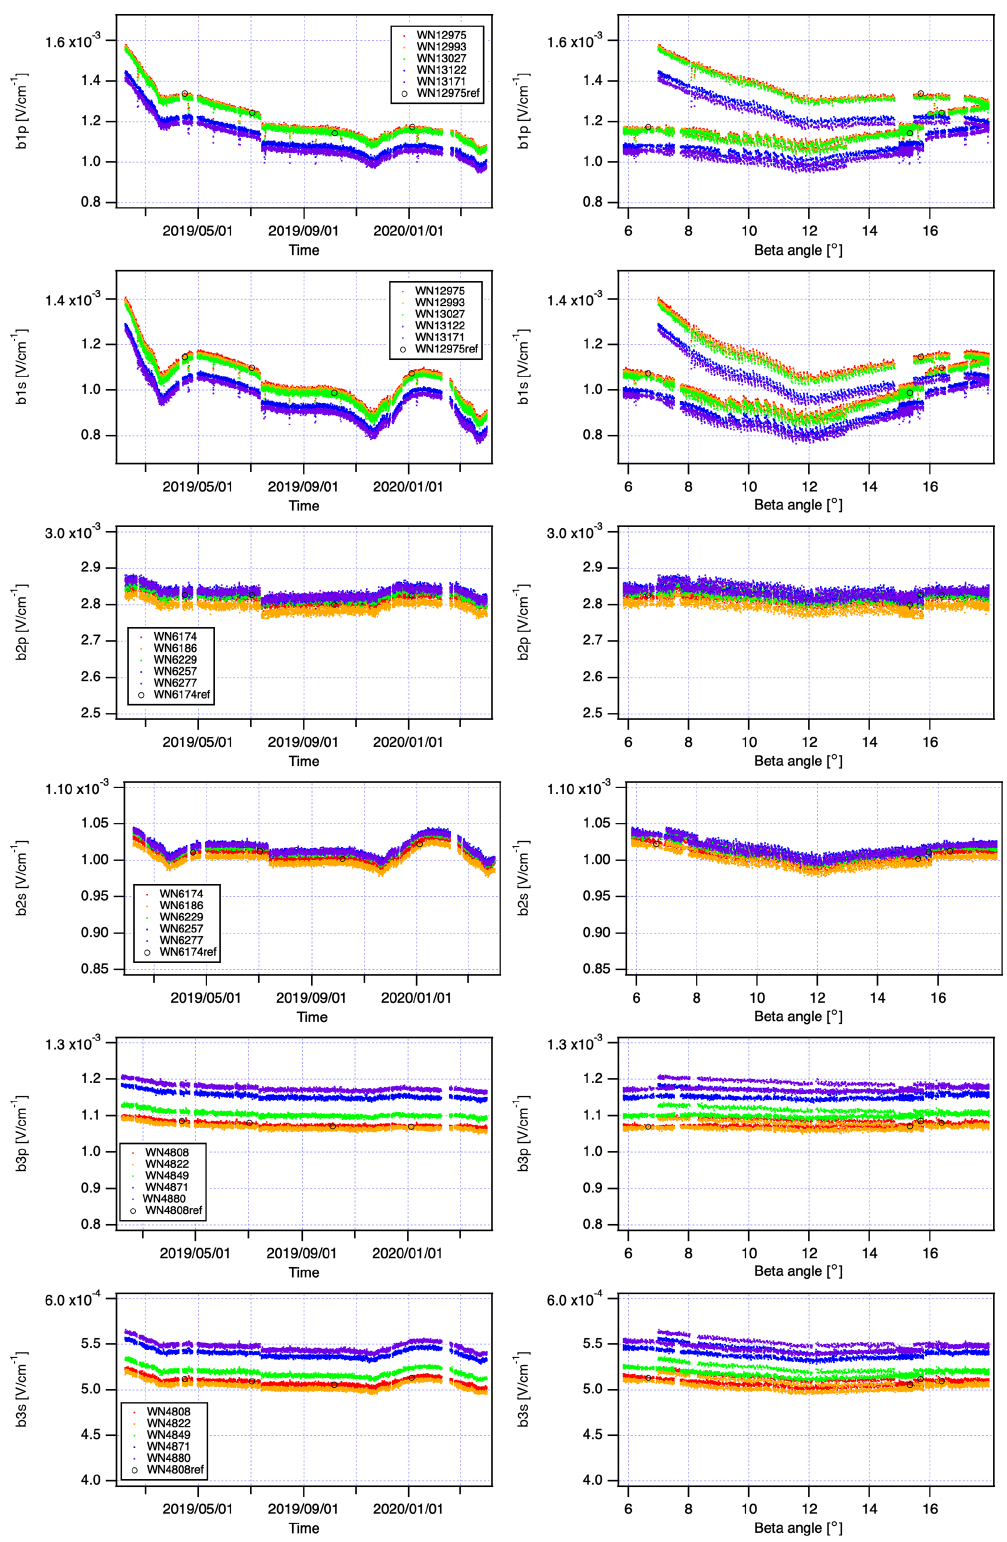
Figure 10. Time- and beta-angle dependent diffused solar signal level for the SWIR region: left panels, time dependency; right panel, beta-angle